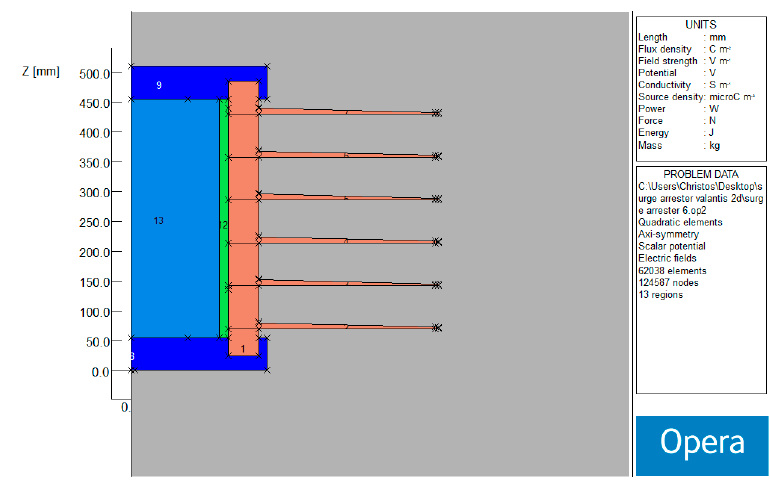
Figure 5. Arrester’s model with increased varistor diameter.